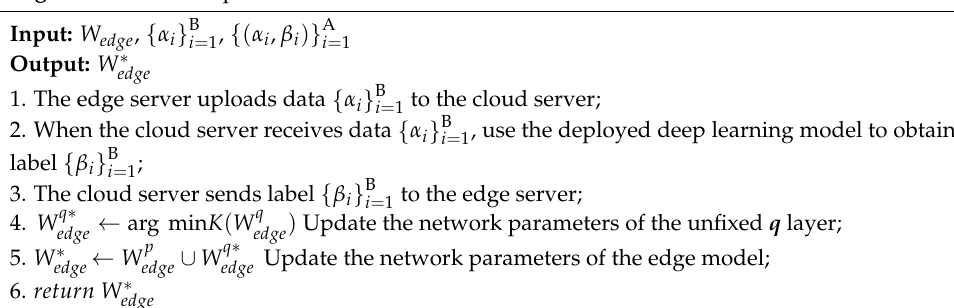
Algorithm 2 Model